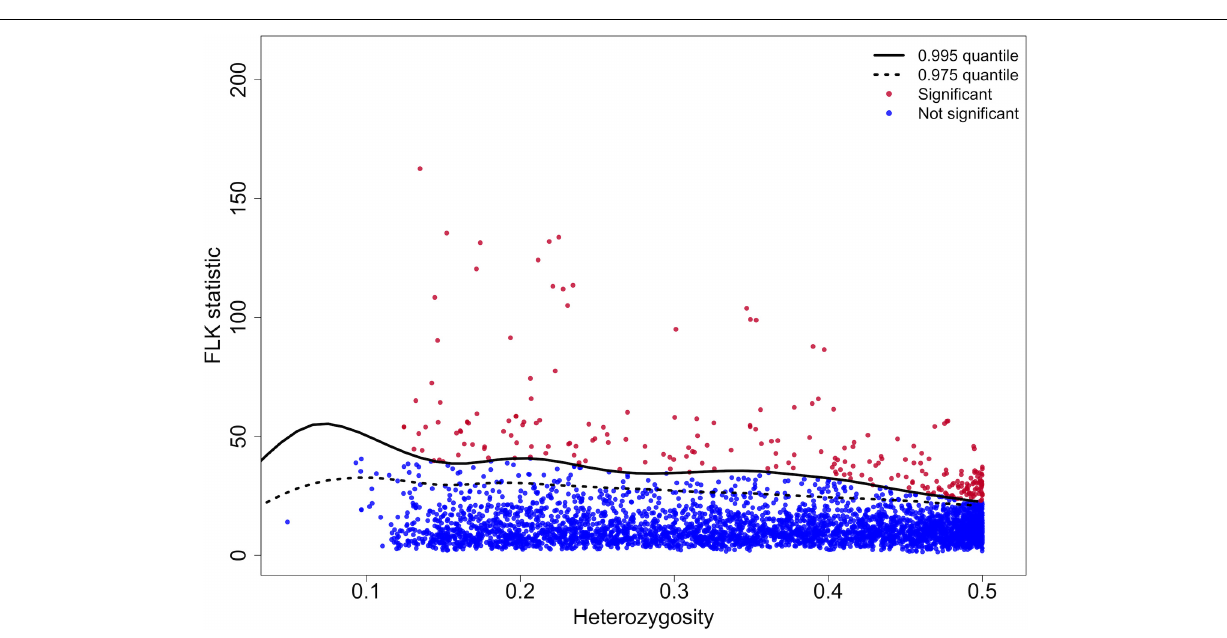
FIGURE 6 | Genome-wide FLK test statistics and simulated 0.995 and 0.975 quantiles. The x-axis is the SNP heterozygosity, and the y-axis is the FLK statistic. The solid line indicates the significance threshold. Significant SNP outliers are highlighted with red color above the solid line, consistent with among-population differentiation above that expected from genetic drift